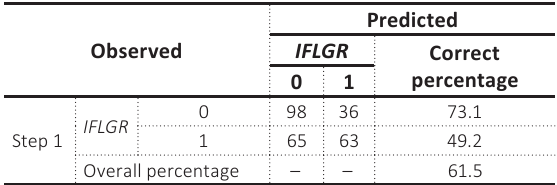
Table 9. Model accuracy test results